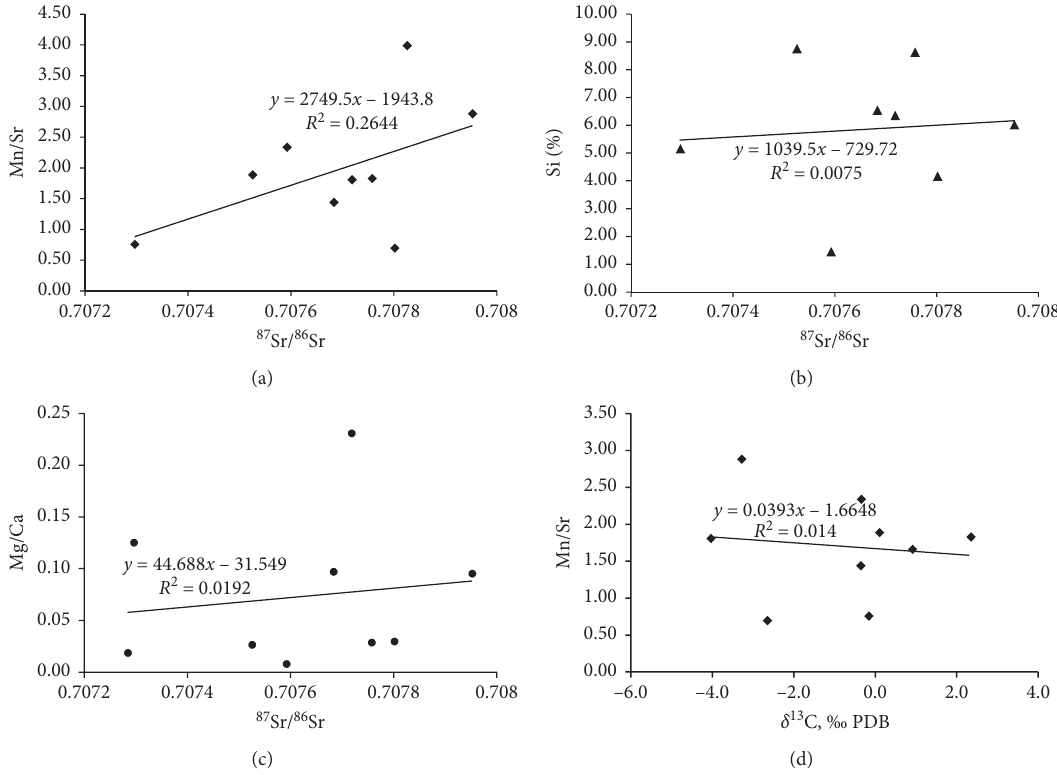
Figure 4: The relationship to distinguishing the diagenesis of the Linxi Formation samples: (a) relationship between the 87 Sr/ 86 Sr values and Mn/Sr values; (b) relationship between the 87 Sr/ 86 Sr values and Si contents; (c) relationship between the 87 Sr/ 86 Sr values and Mg/Ca values; (d) relationship between the δ 13 C values and Mn/Sr